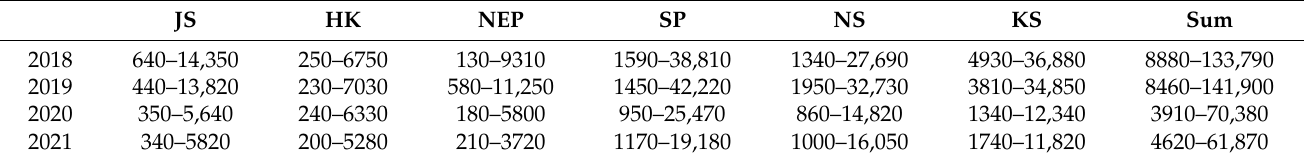
Table 1. Estimates of floating macroalgae biomass ( × 10 3 kg wet weight; a total of one year) detected outside continental shelves (deeper than 200 m) in each subarea shown in Figure 2. The values range from the lowest (sFAI min = 99.99% and sFAI max = 0.1) to the highest value (sFAI min = 99.7% and sFAI max =